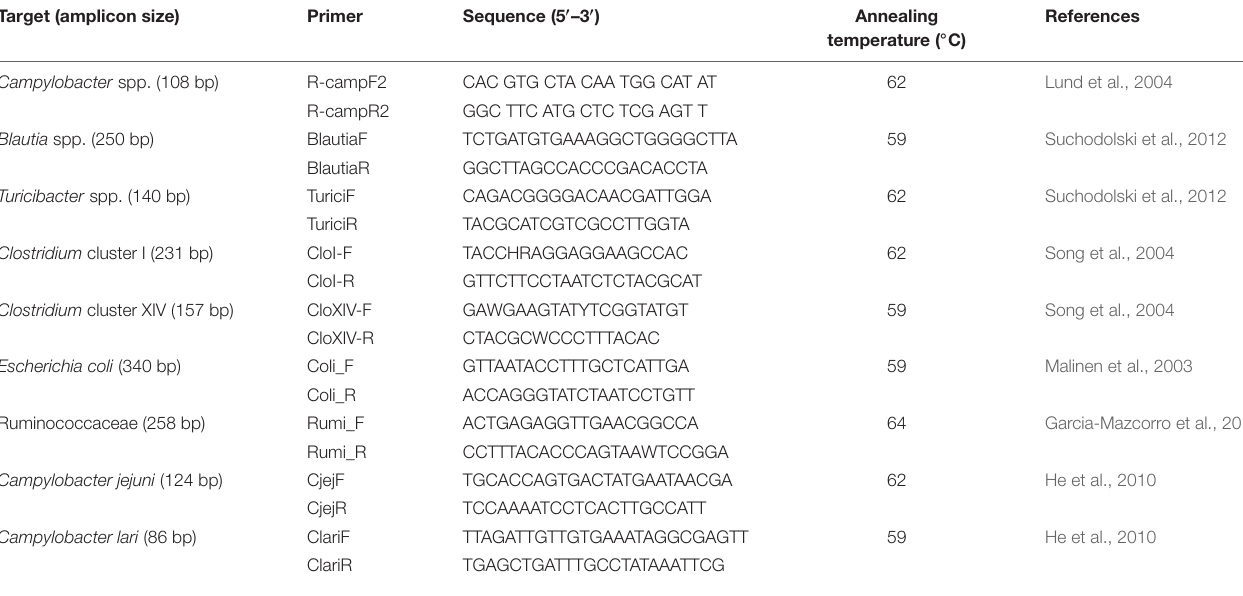
TABLE 2 | Primers used in the qPCR